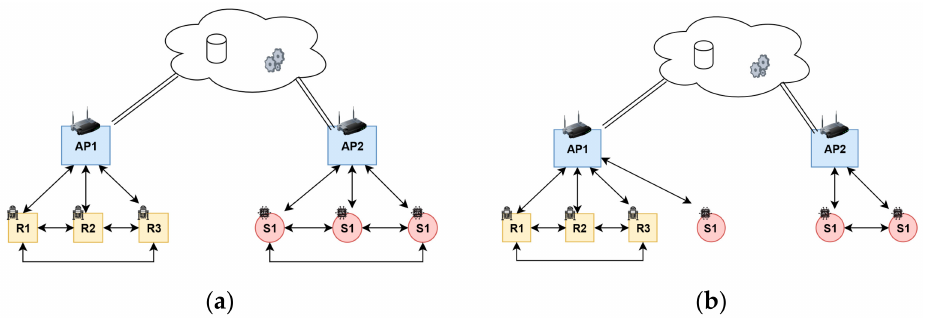
Figure 8. Communication scenario: ( a ) initial position of each robot; ( b ) displacement of a robot from one area of Fog coverage to another area